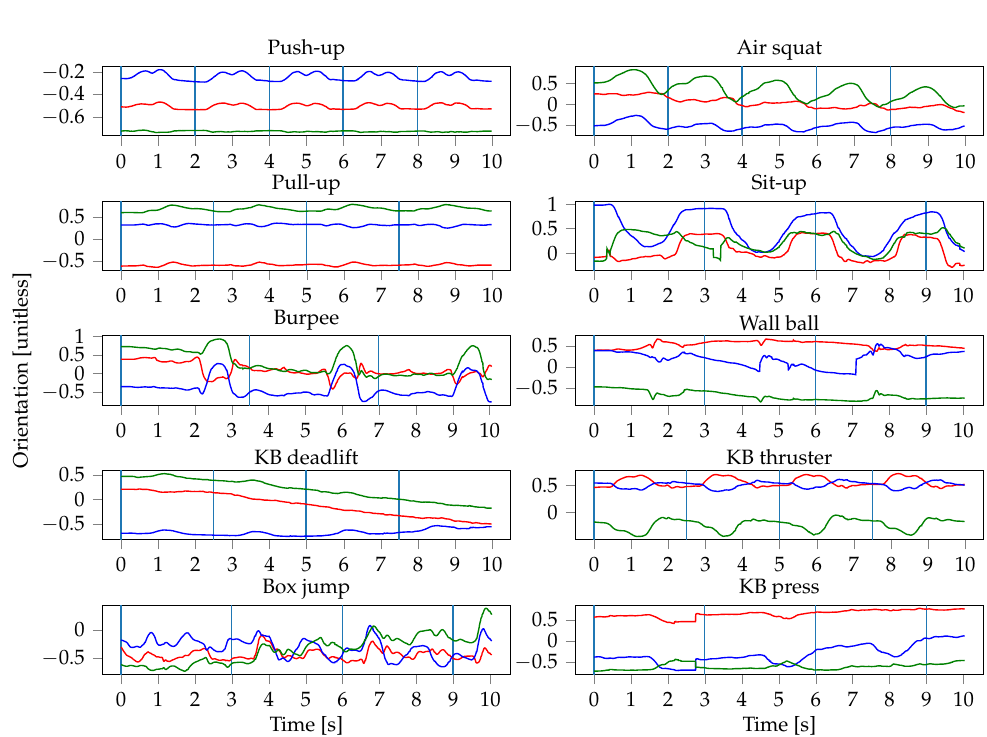
Figure A3. Orientation raw readings for 10 s, for all exercises.